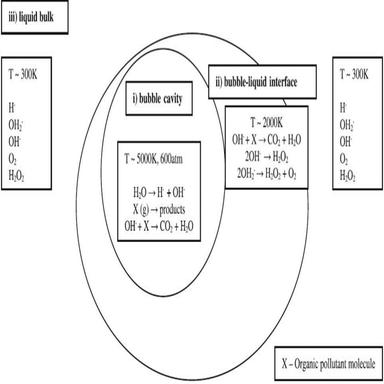
Three different regions of a sonochemical process and the reaction pathway for the degradation of toxic organic pollutants (, Copyright (2020) American Chemical Society.